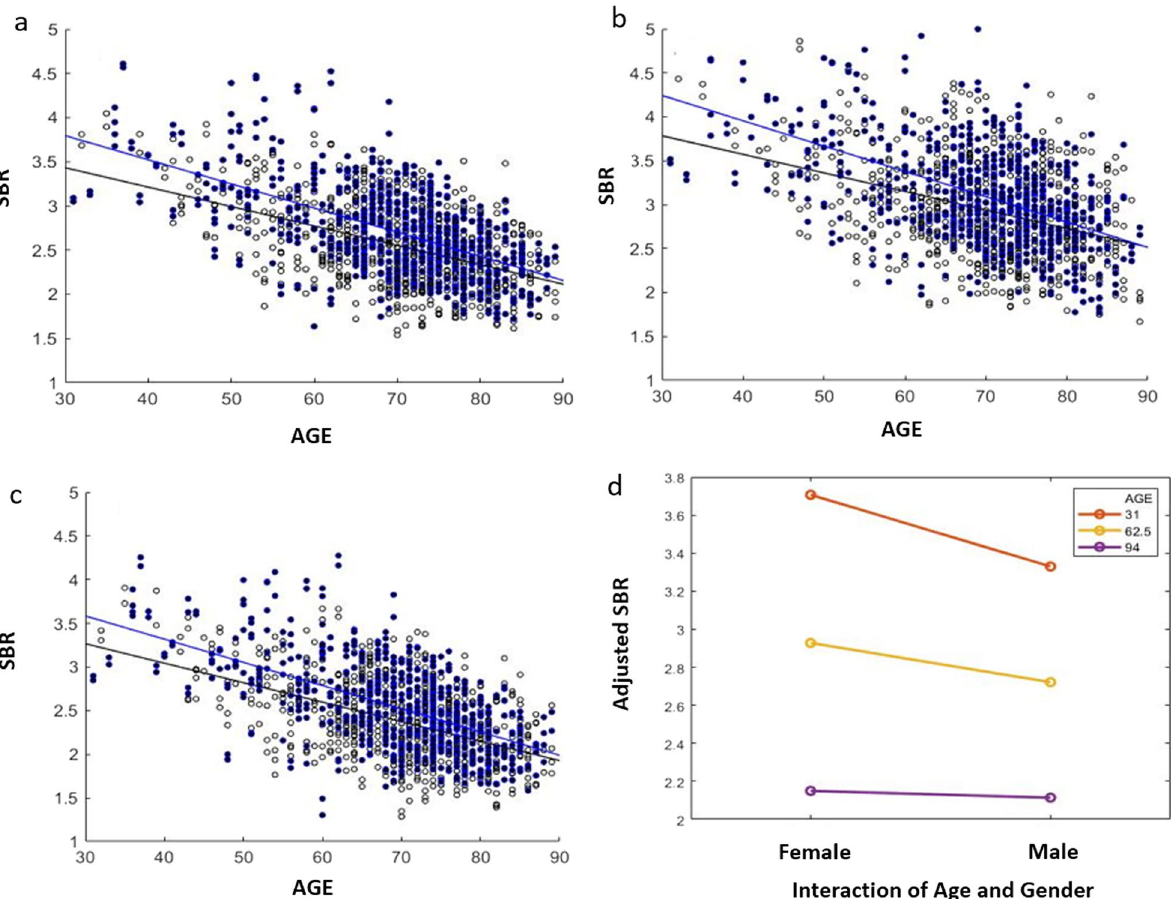
Fig. 2 Scatterplots of ScanOnlyDB 123 I FP-CIT SBR (Chang AC) values as a function of age for both male (open circle) and female (blue circle) for the three VOIs: Striatum ( a ), Caudate ( b ), and Putamen ( c ). Data relevant to each gender were independently fitted by linear regression lines (solid black line for males and solid blue line for females) and superimposed on each respective scatterplot. Age-gender interaction of striatal SBR for a mean age of 31 years (orange), 62.5 years (yellow), and 94 years (purple) is shown in ( d )